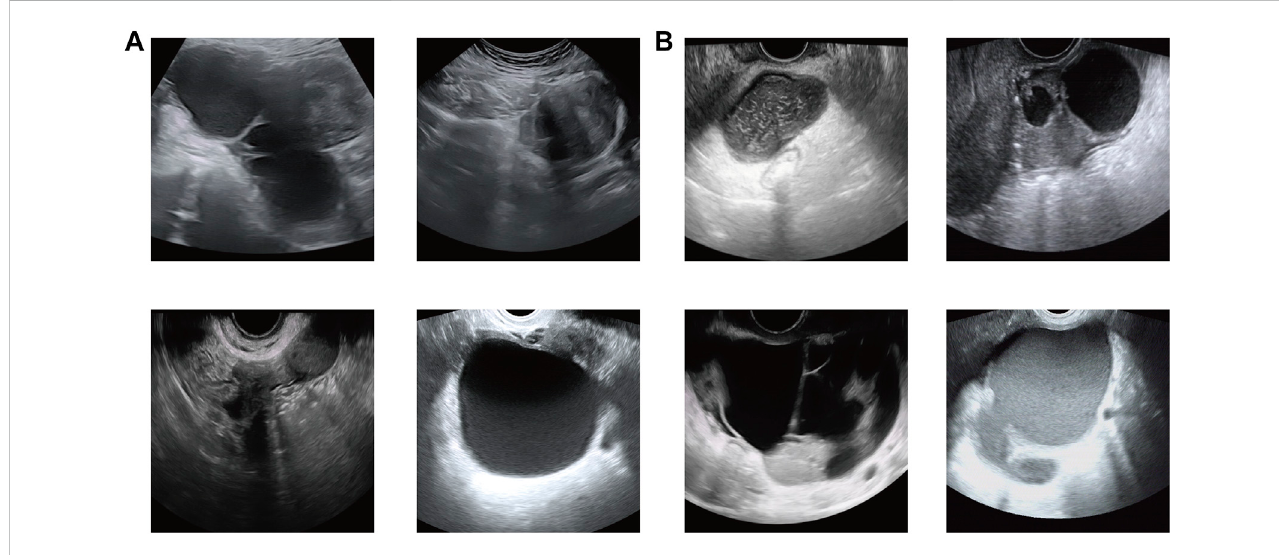
FIGURE 2 Sample dataset image in this study. (A) Ovarian endometriosis cyst (OEC) and (B) tubal-ovarian abscess